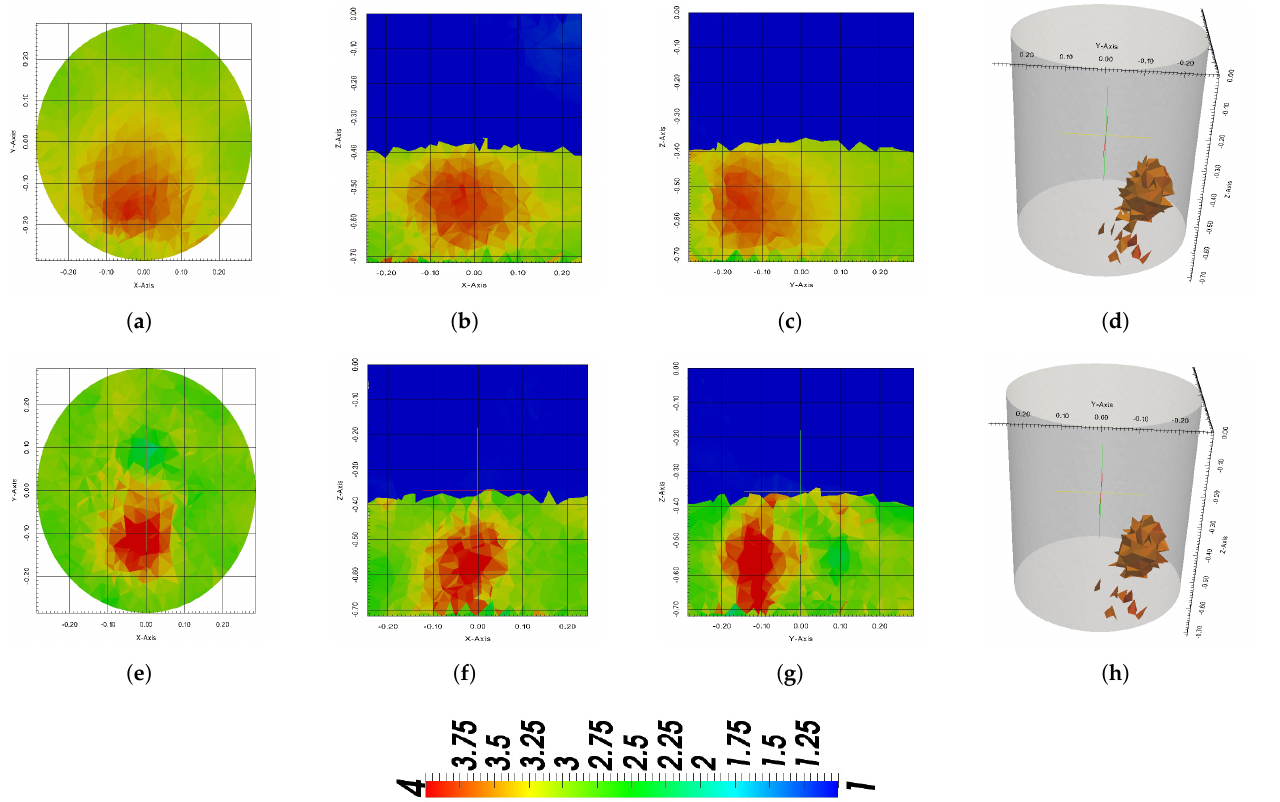
Figure 10. Full 3D Re ( (cid:101) r ) image when using FLAs. The top row is the reconstruction of 260 MHz data, the bottom one is 570 MHz. ( a , e ) show the x - y plane, ( b , f ) show the x - z plane and ( c , g ) show the y - z plane. Images ( d , h ) show 3D threshold images with all cells Re ( (cid:101) r ) > 3.6 solid. The color scale shown at the bottom is common to all images in this